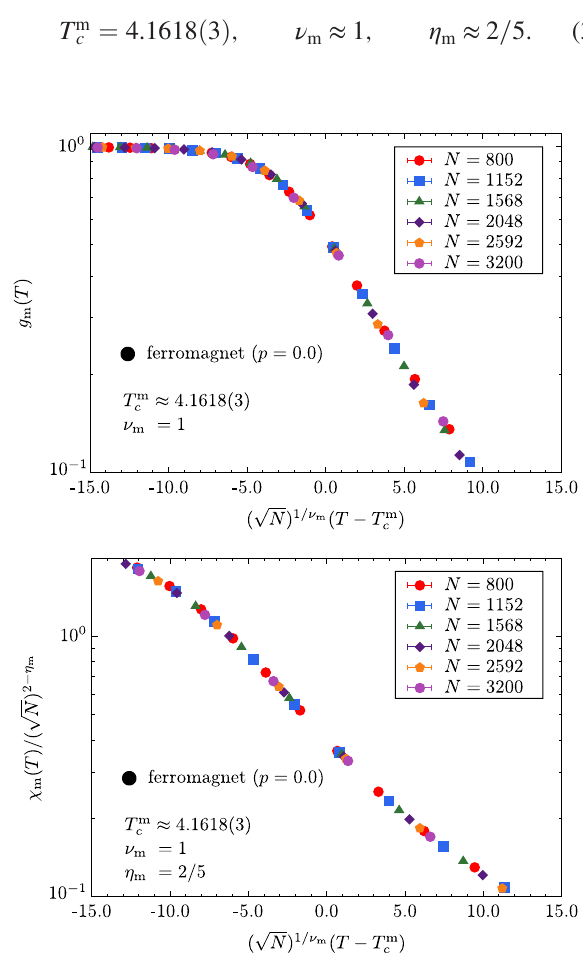
FIG. 3. Top panel: Finite-size scaling of the ferromagnetic ffiffiffiffi p N Binder parameter g as a function of ð Þ 1 = ν m ð T − T m c Þ and m p ¼ 0 (pure ferromagnet) on the Chimera topology. The data 4 . 1618 ð 3 Þ and ν 1 . Bottom panel: scale very well for T m c ¼ m ¼ Finite-size scaling of the ferromagnetic susceptibility χ . Plotted ffiffiffiffi ffiffiffiffi p p m = ð N N are χ Þ 2 − η m vs ð Þ 1 = ν m ð T − T m c Þ . The data scale very well m ≈ 4 . 1618 ð 3 Þ , ν 1 , and η 2 = 5 . Error bars are for T m c m ¼ m ¼ smaller than the